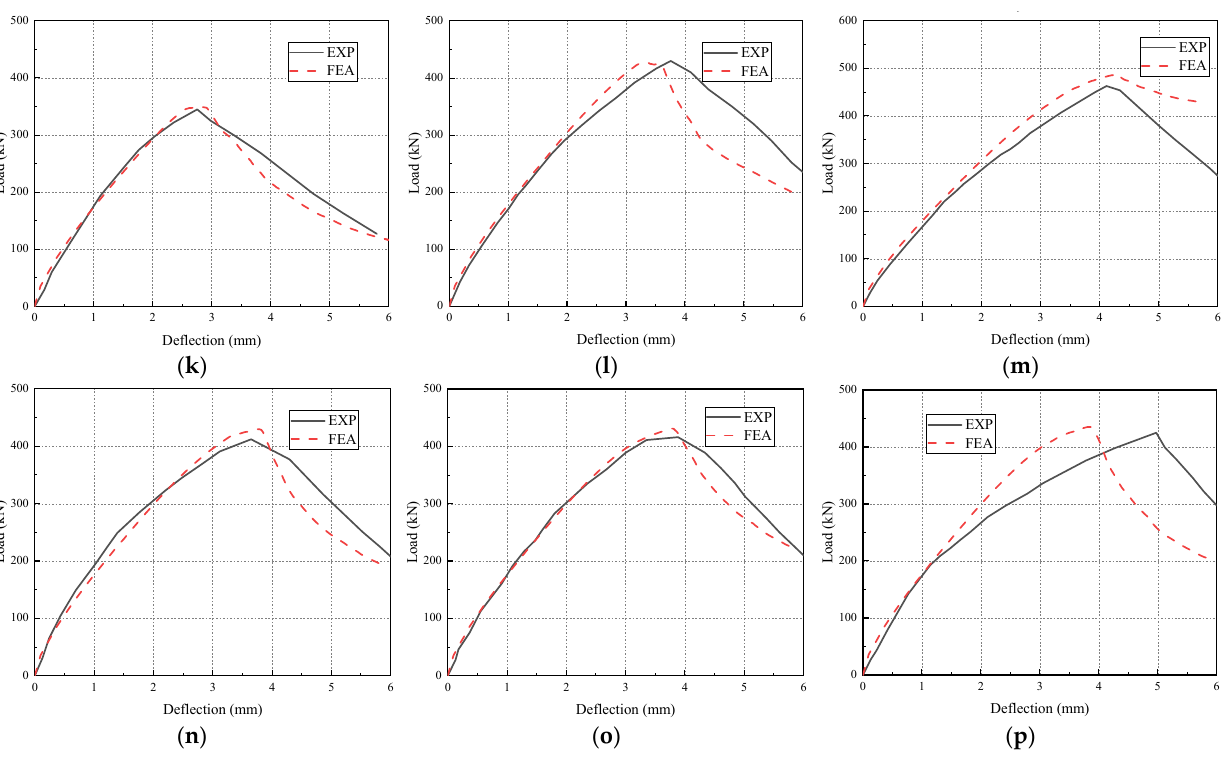
Figure 13. Comparison of load–deflection curves between test and simulation: ( a ) UA; ( b ) UB; ( c ) UC; ( d ) UD; ( e ) S1; ( f ) S3; ( g ) S4; ( h ) C1.5; ( i ) C2; ( j ) L6; ( k ) L8; ( l ) L12; ( m ) L15; ( n ) T2; ( o ) T3; ( p ) T4.